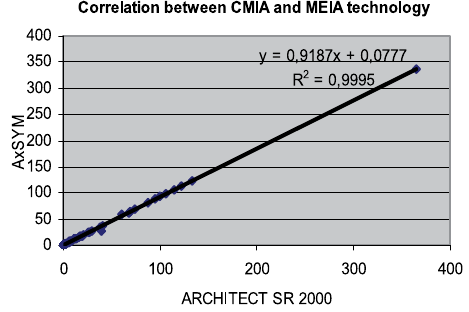
FIGURe 1. Comparison of TnI concentration (ng/ml) in se - rum measured by Architect CmIA (x-axis)and AxSym mEIA technology (y-axis).